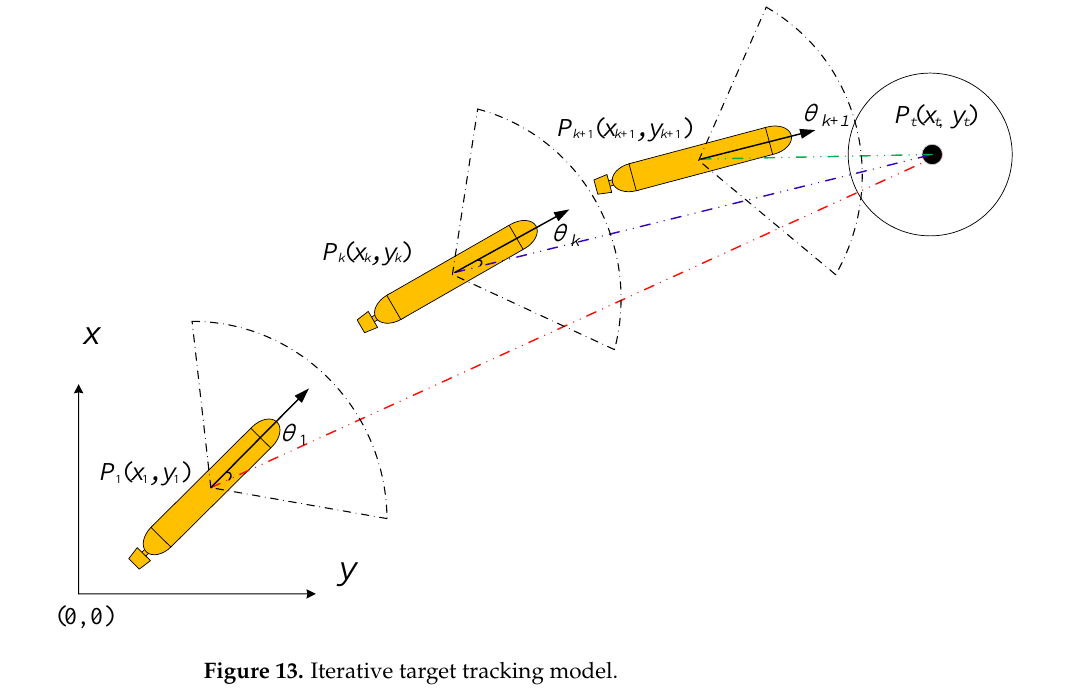
Figure 13. Iterative target tracking model.